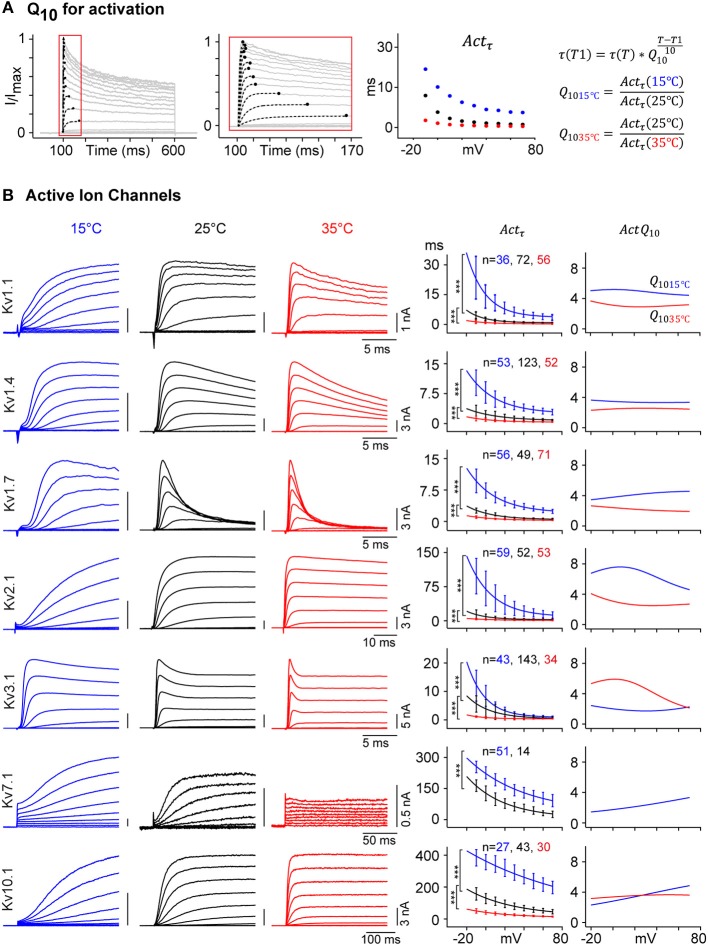
Temperature dependence of Kv channel kinetics. (A) Voltage-dependent Actτ is measured as shown in Figure 2. Q10 of Actτ is calculated for 15 and 35°C, with 25°C as a reference. (B) Representative current traces for selected Kv channels in response to activation protocol at 15°C (blue), 25°C (black), and 35°C (red) are shown (left panels), the amplitude in nA and time in ms are indicated with scale bars. Single exponential curve is fitted to the median value of Actτ for each of the three temperatures (middle panel, solid line; ***p-value < 1e-5, Student's t-test). For each selected Kv channel, Q10 values for 15°C (blue) and 35°C (red) are plotted against command voltage (right panel). For a given Kv channel, Q10 value is different for different temperature range and vary between 2 and 8 across different voltages. For Kv7.1, which becomes electrically silent at 35°C, Actτ and Q10 values for 35°C are not plotted. Error bars are ± S.D.